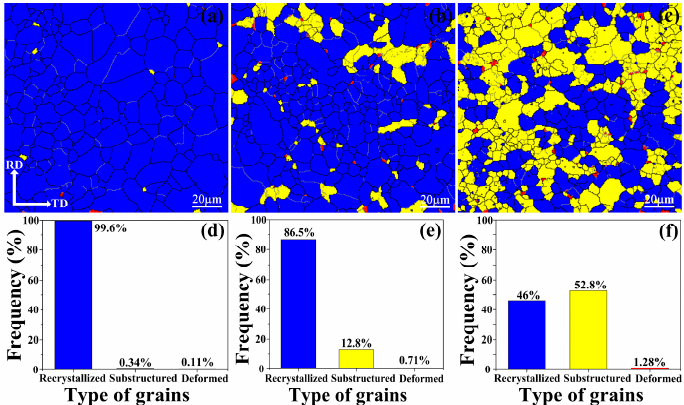
Figure 4. Different grains types of hot-rolled ( a ) Mg–1Sn–1Zn–0.5Ca, ( b ) Mg–3Sn–1Zn–0.5Ca, ( c ) Mg–5Sn–1Zn–0.5Ca, alloys and corresponding frequency of the different grains types ( d ), ( e ) and ( f ).